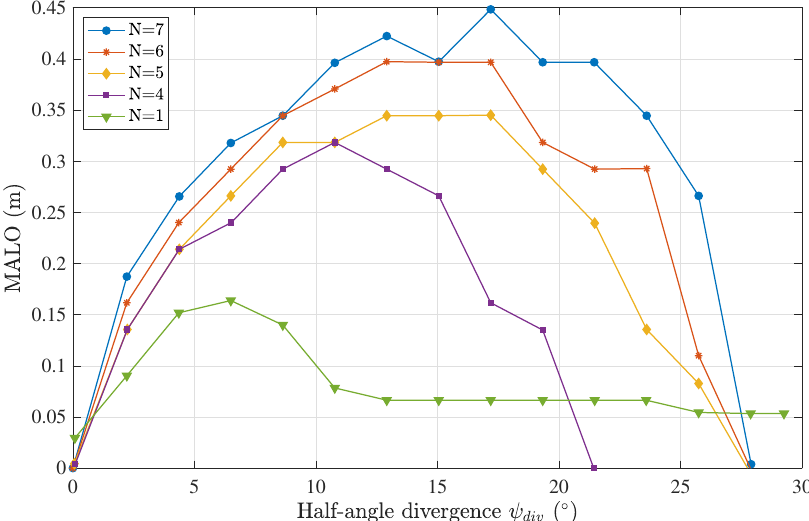
Figure 10. MALO calculation as a function of the divergence of the emitter for a different number of sensors in the sensor scheme, considering a clear water type and a Tx-Rx distance of